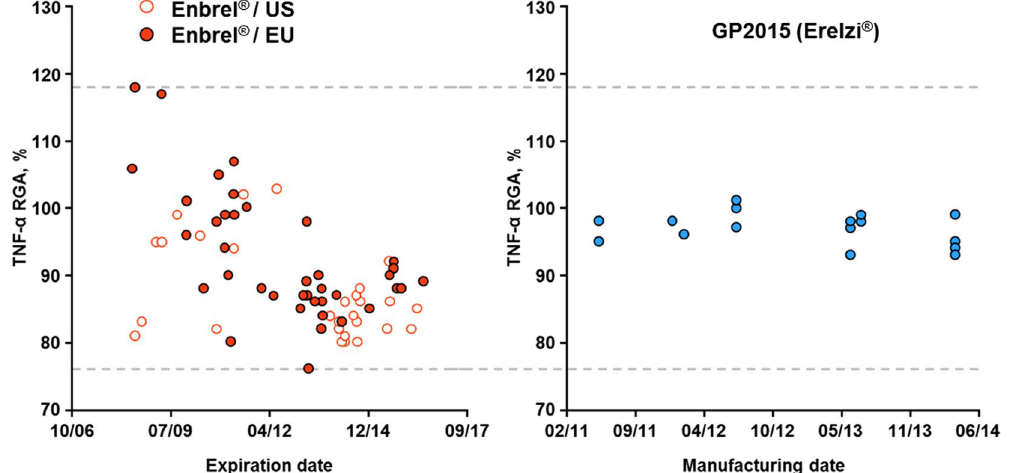
Figure 5. Assessment of potency variability over time. Assessment of potency in reference product Enbrel ® batches sourced from both the EU and US since 2008 reveals a broad distribution with a tightening of values toward the lower end over time, likely due to one or more process changes. Assessment of potency for GP2015 (Erelzi ® ) batches over time reveals low batch to batch variability well within the clinically verified range of the reference product. Manufacturing dates are given as